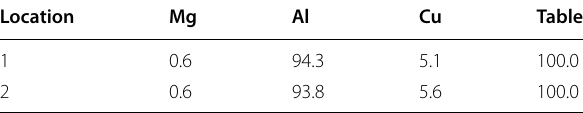
Table 3 EDX quantification results (wt%) indicated in Figure 6b